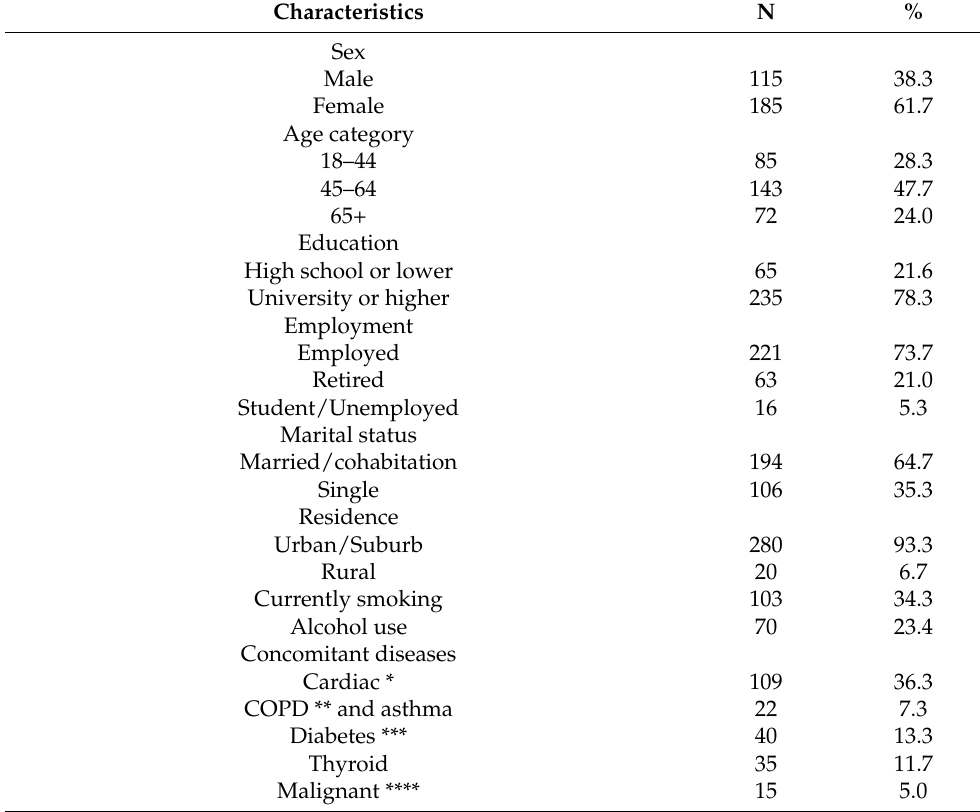
Table 1. Characteristics of the study participants ( n =